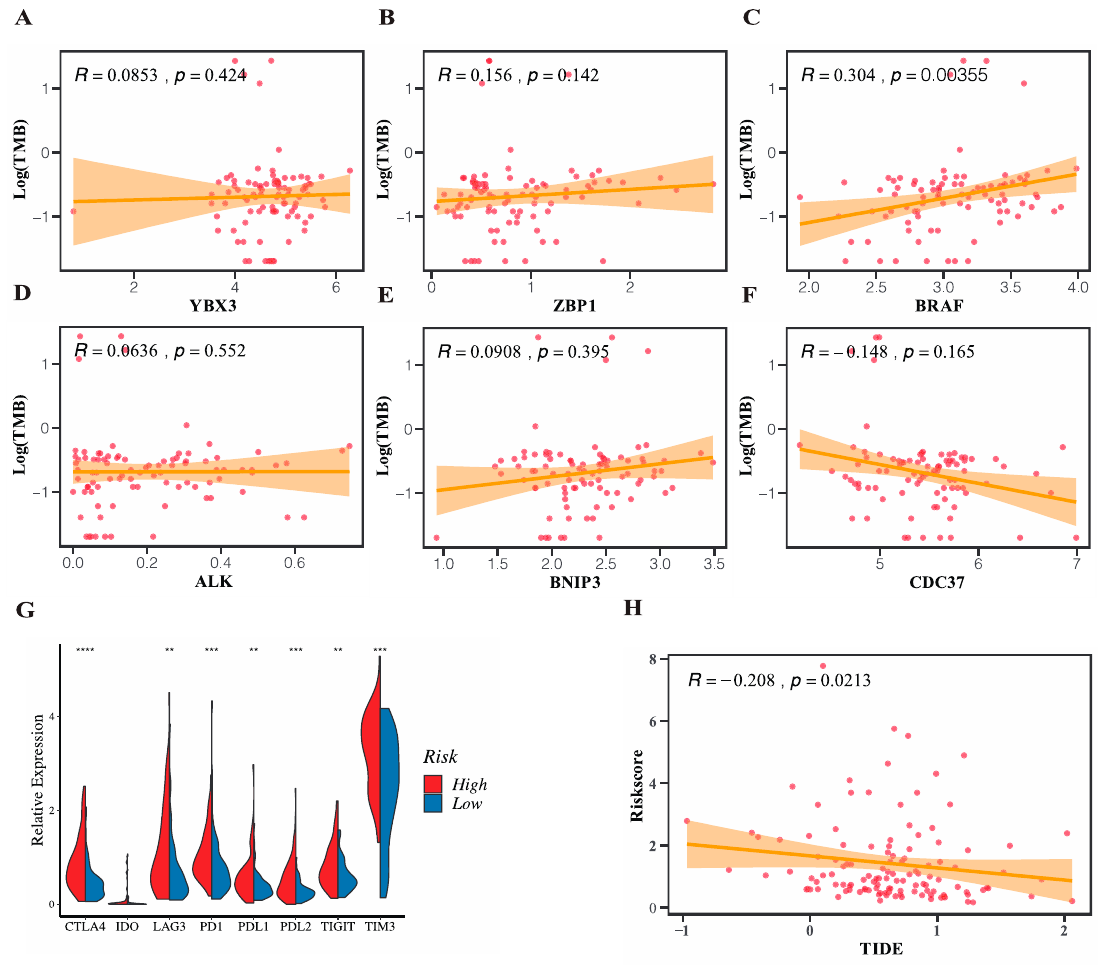
Figure 8. Evaluation of potential value of the risk model in the ICB immunotherapy in TCGA cohort. ( A – F ) Correlation of the 6 genes in the signature with TMB. ( G ) Differences of expression profiles of common checkpoint genes in the two risk subgroups (Wilcox text, ** p < 0.01; *** p < 0.001, **** p < 0.0005). ( H ) Correlation between the risk score and TIDE score (Spearman test, p < 0.05).